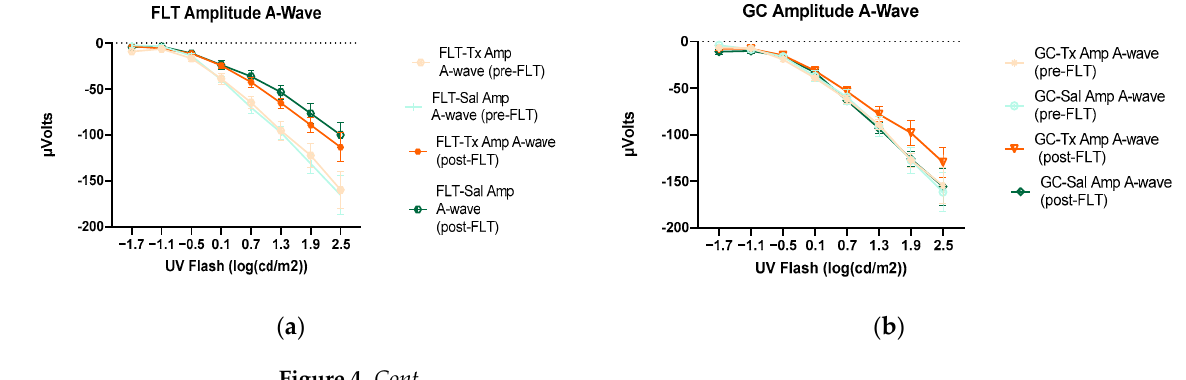
Figure 3. Representative electroretinography (ERG) of the flight (FLT) and habitat control (GC) mice over time. ERGs were obtained in response to the flash intensity of 2.5 log cd · s/m 2 . ( a ) FLT-saline vs. GC-saline. ( b ) FLT-saline vs. FLT-BuOE.